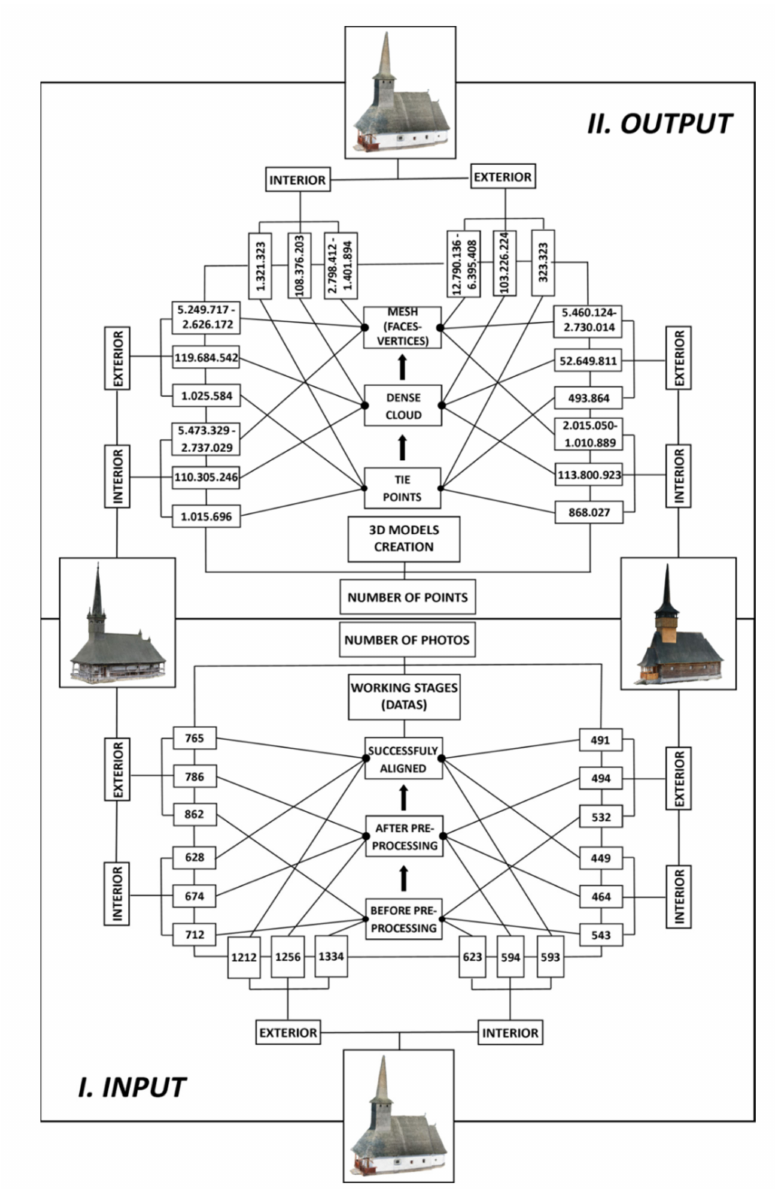
Figure 5. Quantitative graphical representation of the size of the data sets entered, and the results obtained after each stage of the pre-processing and